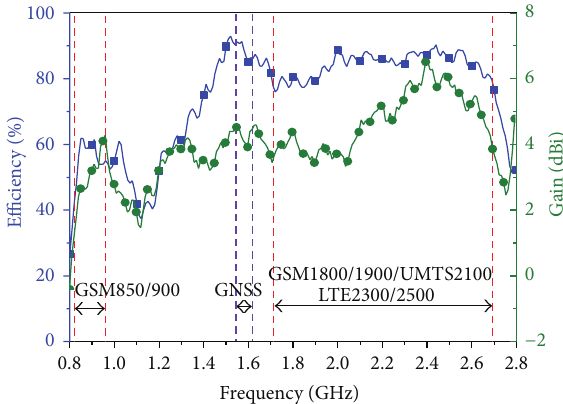
Figure 8: The measured gain and efficiency of antenna.